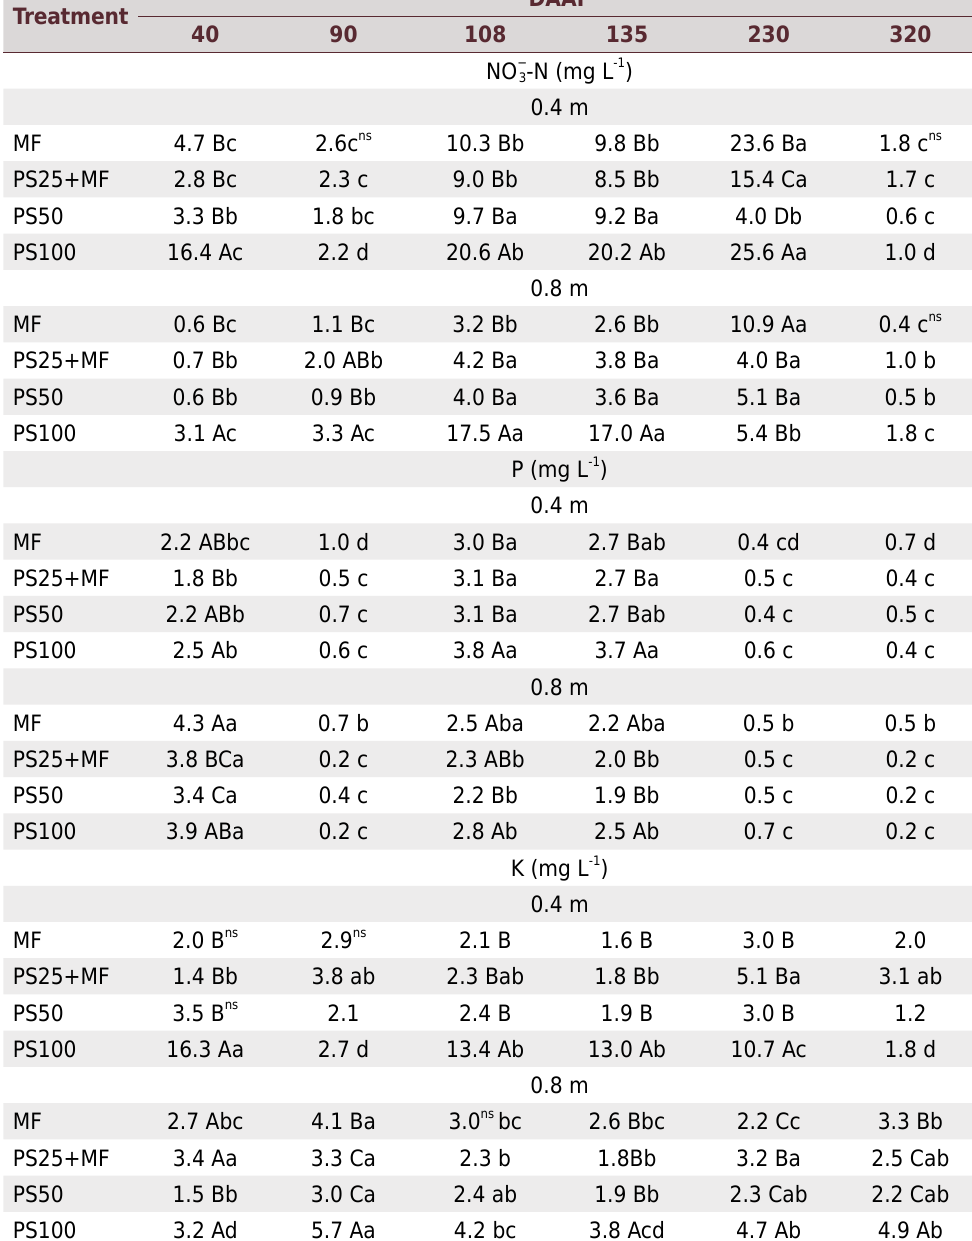
Table 3. Soil solution content of nitrate in a Typic Hapludox under 12 years of no-tillage corn-oat rotation and yearly fertilized with with pig slurry (PS), mineral fertilizer (MF) and pig slurry combined with mineral fertilizer (MF + PS), at two depths (0.4 and 0.8 m), over time in days after fertilizer application